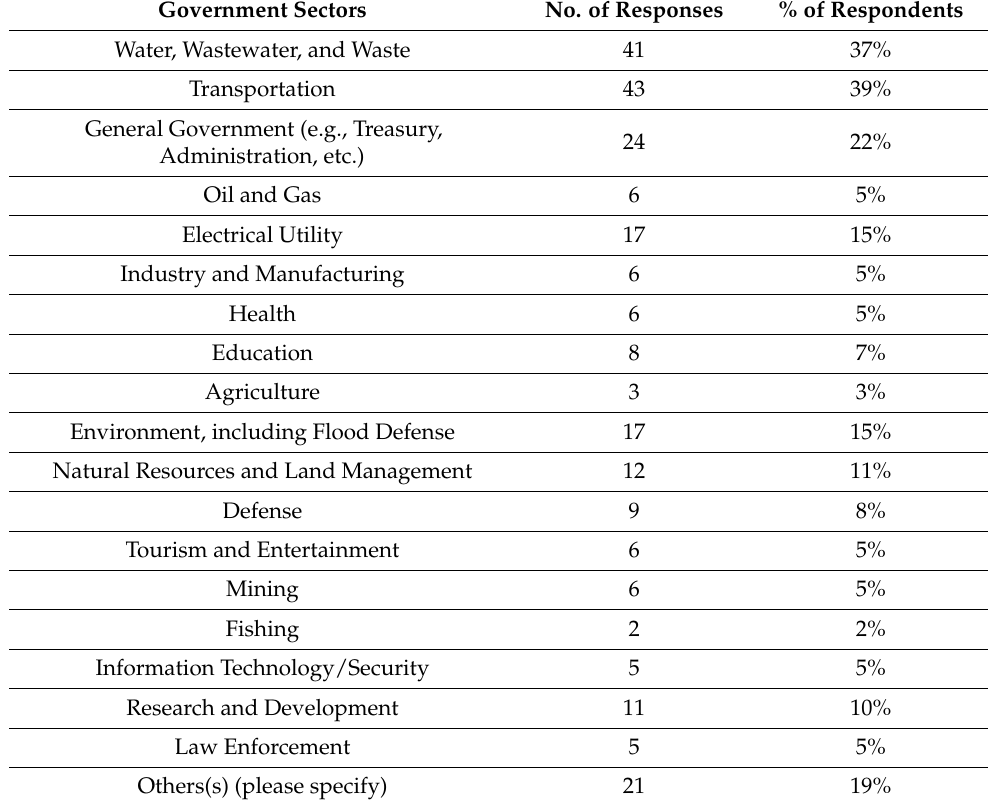
Table 3. Government sectors